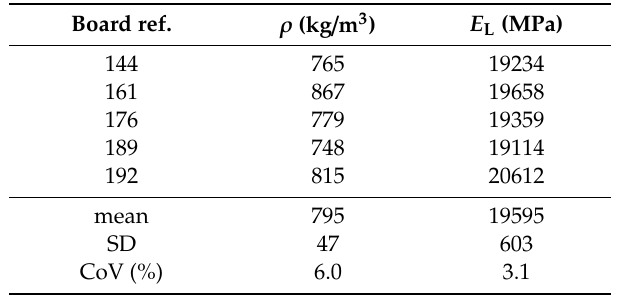
Table 1. Density and elastic modulus of elasticity of E. globulus boards. Board